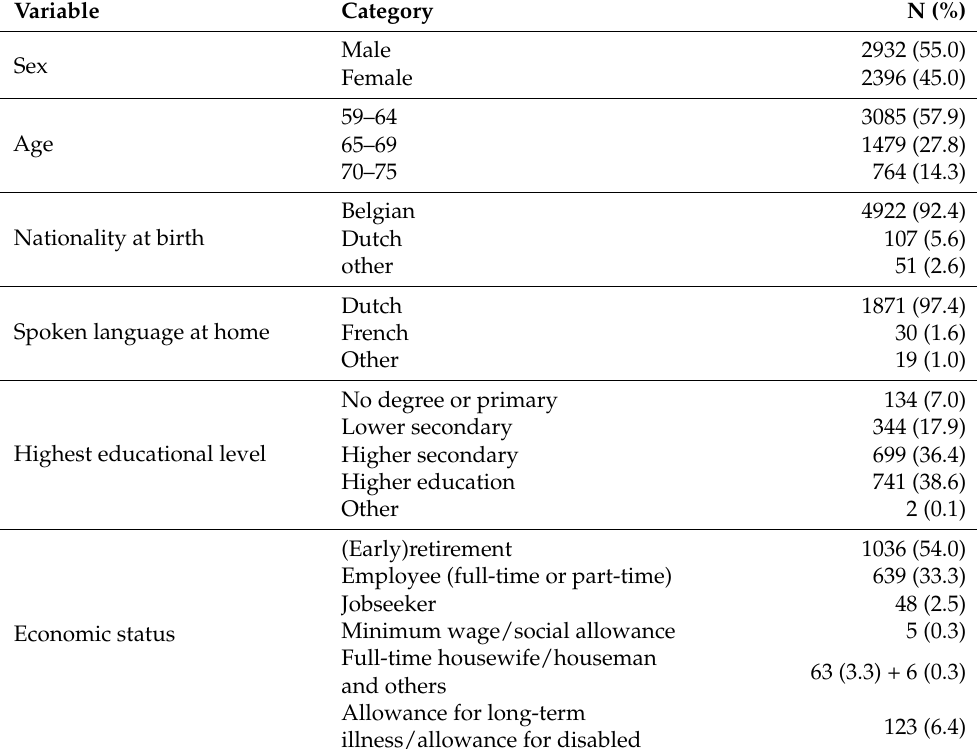
Table 1. Sociodemographic characteristics of the survey respondents (absolute numbers and un- weighted